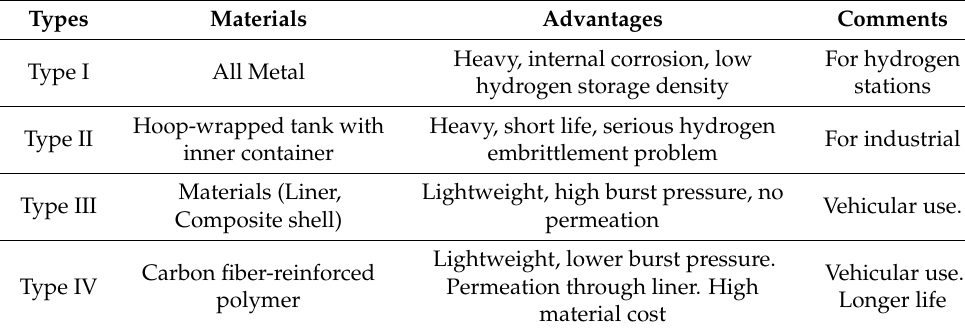
Table 2. Comparison of hydrogen storage